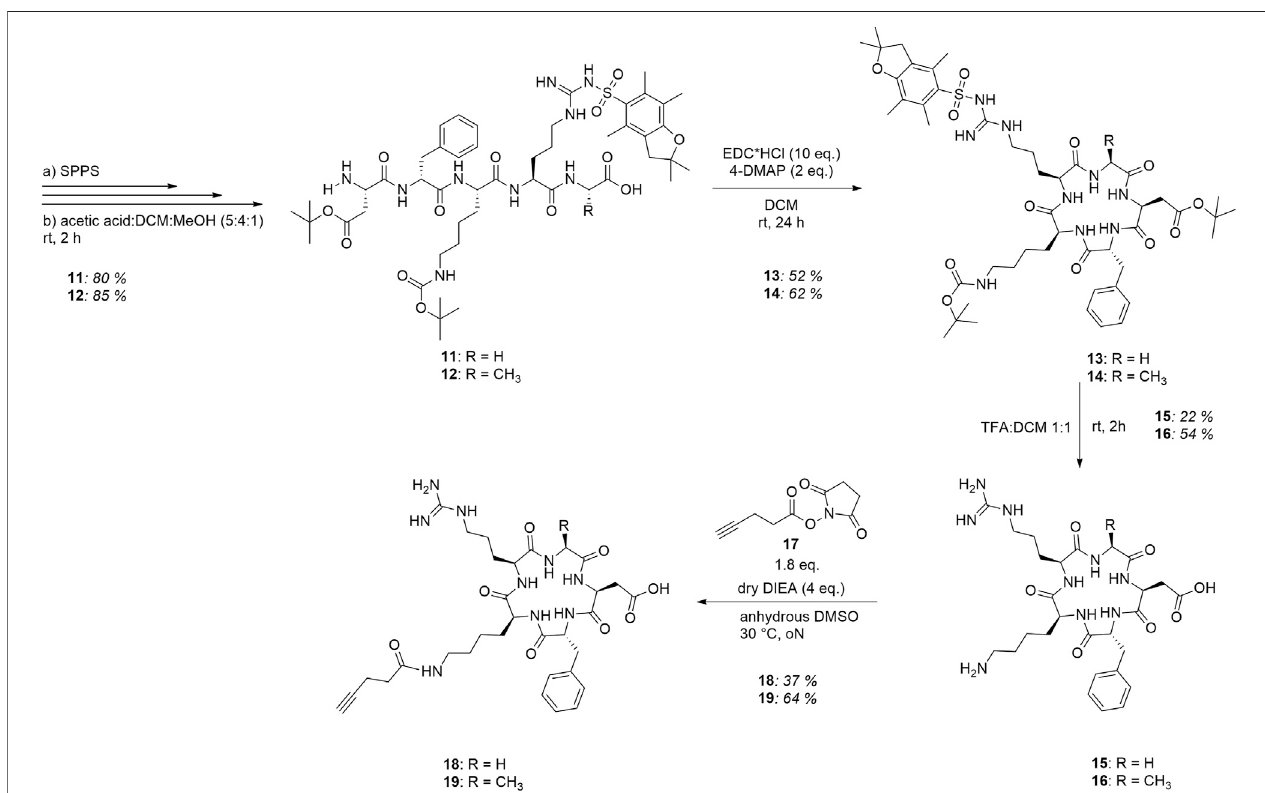
FIGURE 4 | Synthesis route to alkyne-functionalized cyclo [RGDfK] 18 and cyclo [RADfK] 19 , respectively.